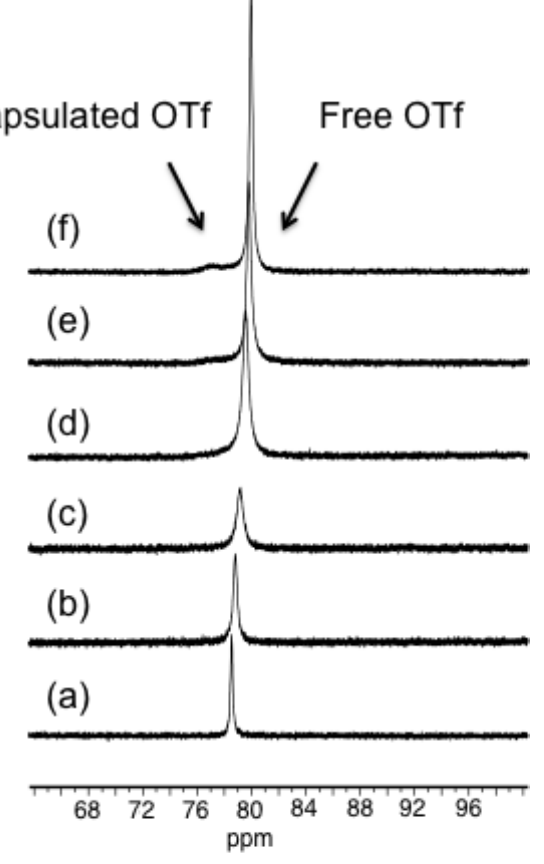
Figure 4. 19 F NMR sprecta of [Pd variable temperature. ( a ) 25 °C; ( b ) 10 °C; ( c ) 0 °C; ( d ) −10 °C; ( e ) −15 °C and ( f ) −20